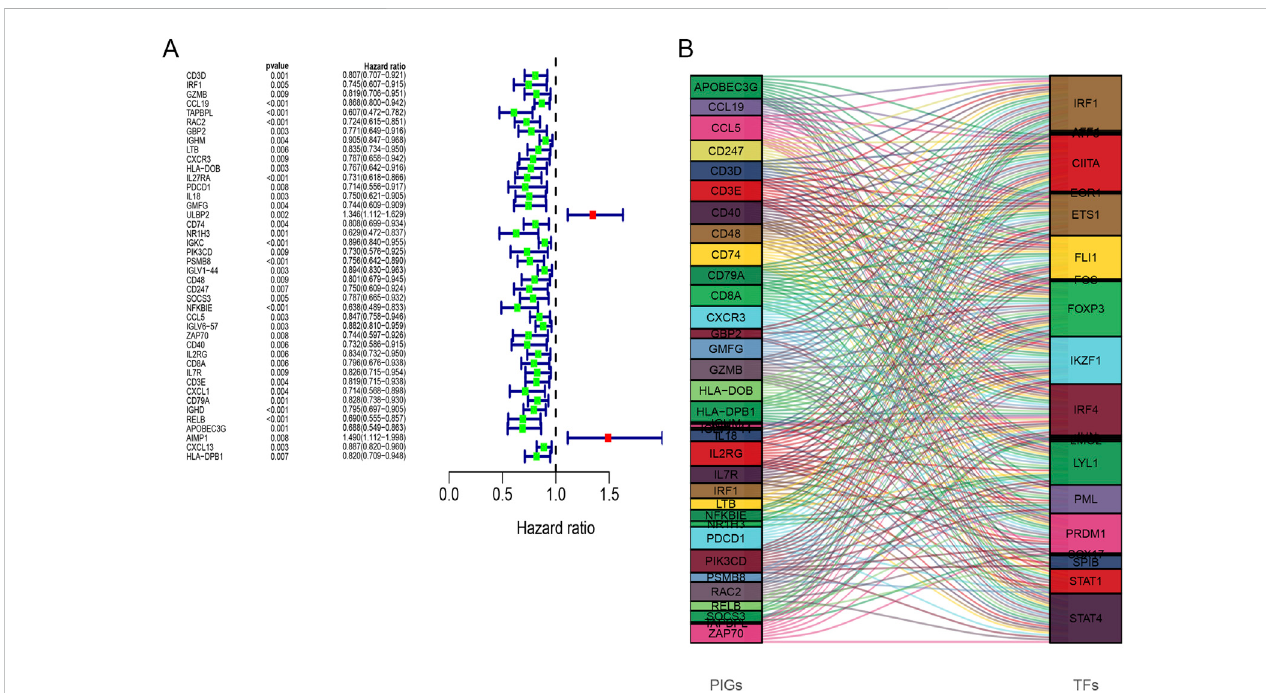
FIGURE 5 (A) Forest plots of hazard ratios for overall survival of 42 prognostic immune-related genes. (B) Sankey diagram illustrating the relationship between 35 prognostic immune-related genes (left) and 21 transcription factors (right) for the same plot. The box height indicates the percentage of TF and PIG varieties, while lines show the